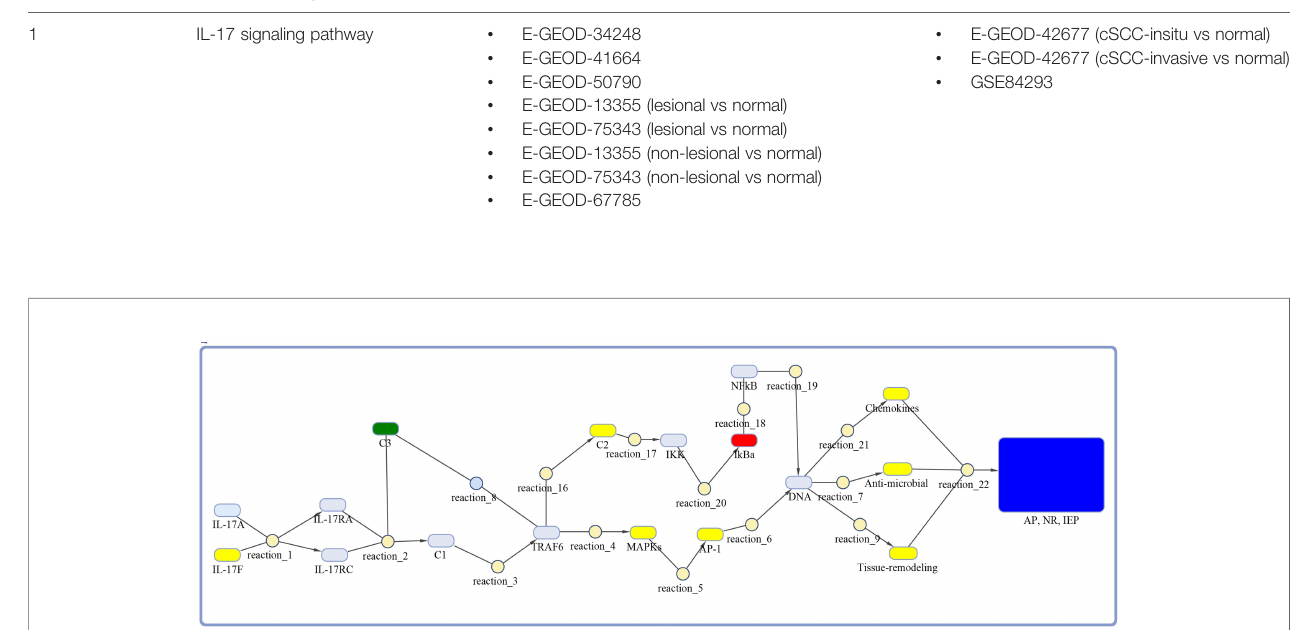
TABLE 4 | Common pathway of both the diseases. The DEGs of both the datasets of psoriasis and cSCC were enriched in IL-17 signaling pathway. Sr. no.